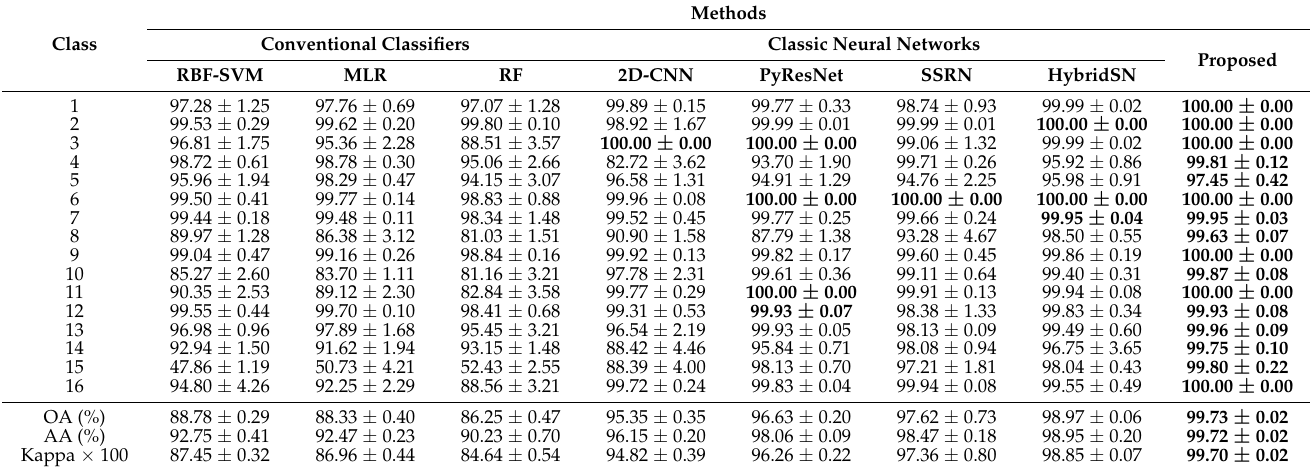
Table 7. The categorized results of different methods on the Paiva of University dataset.